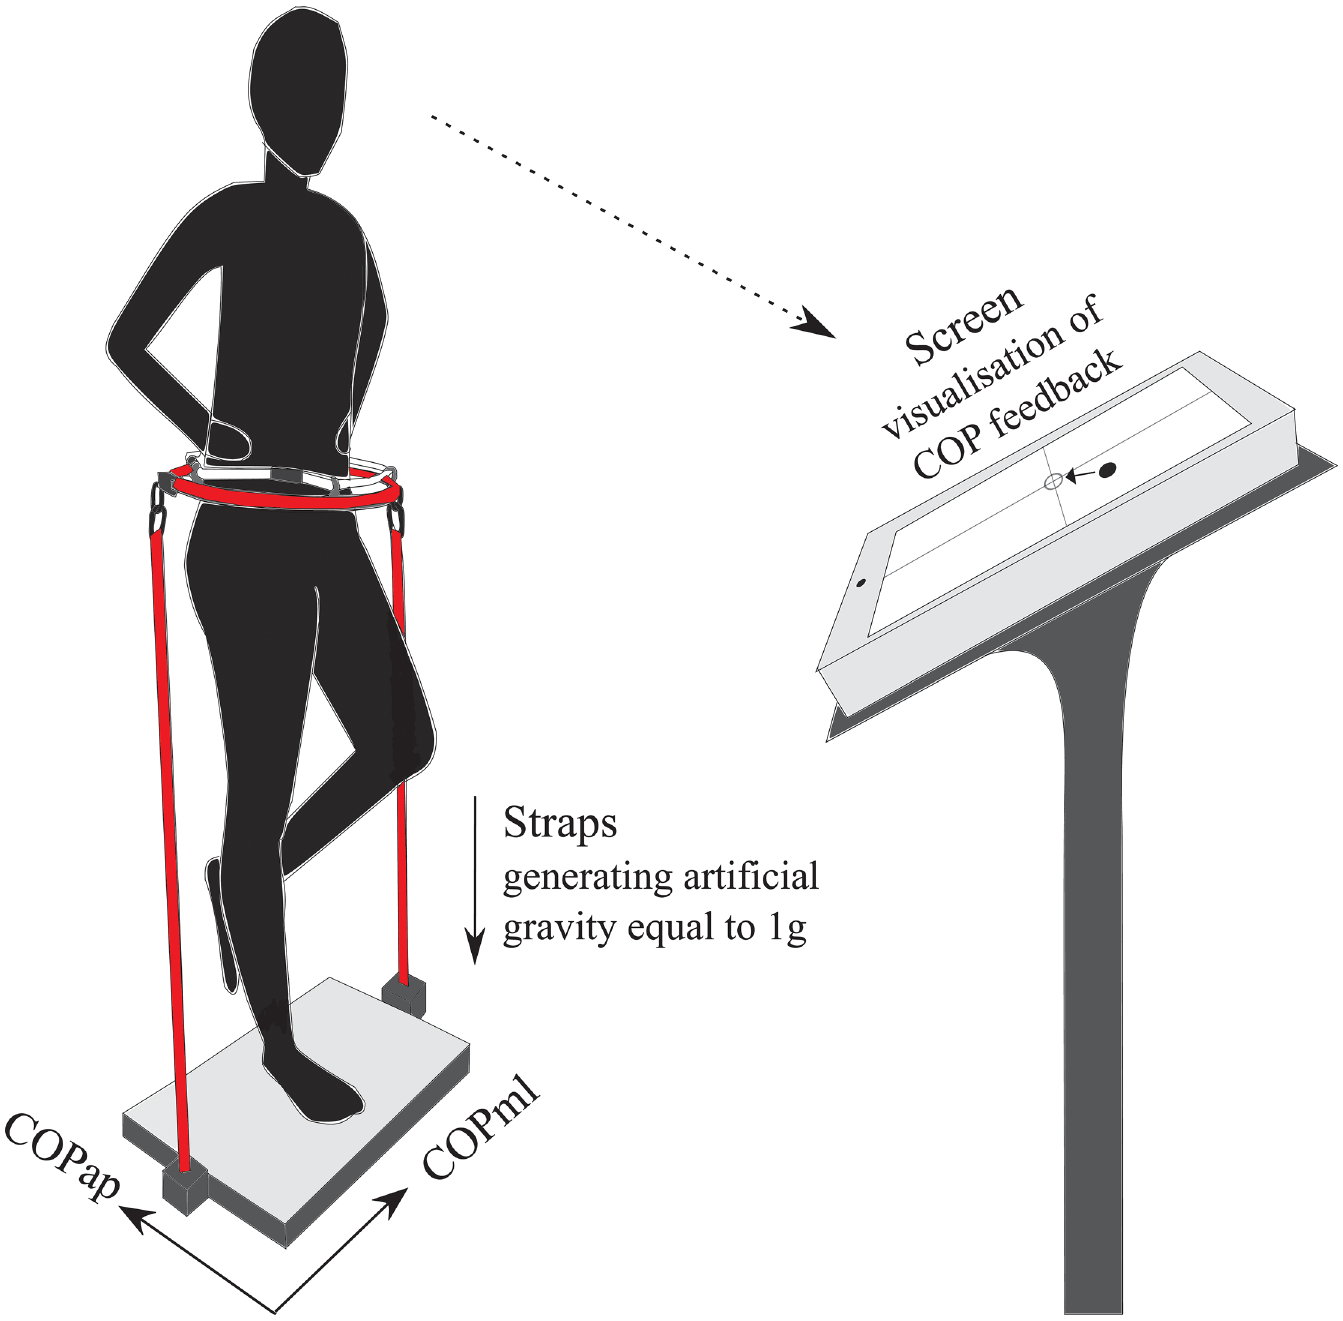
Fig 2. Experimental setting: Artificial loading (loading equal to 1g) was achieved by means of a harness affixed around the subject ’ s hip and attached to the floor via springs close to subject ’ s lateral sides of the right foot. The oil-ring provides freedom of movement to avoid stabilizing effects. In all test conditions, subjects received a COP feedback visualized on a screen in front of the experimental